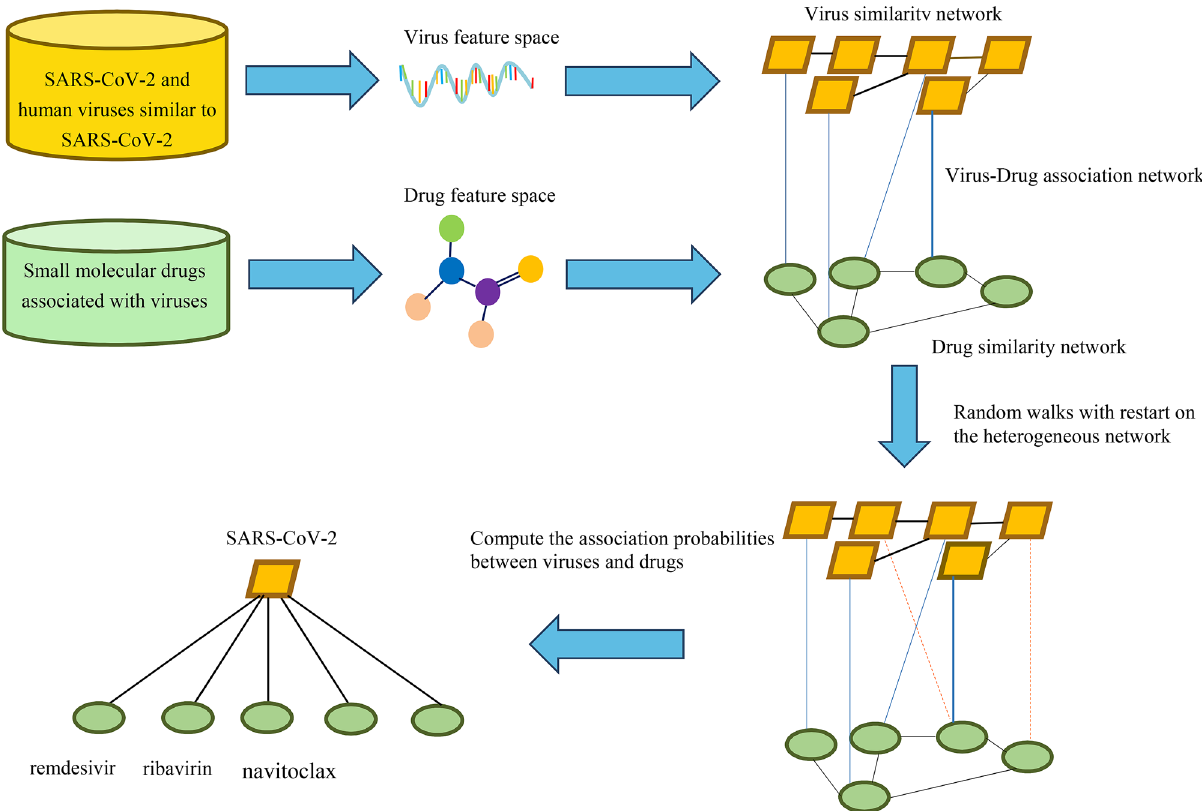
Figure 2. Flowchart of the VDA-RWR method based on the genome sequences of viruses, the chemical structures of drugs, and random walk with restart on the heterogeneous